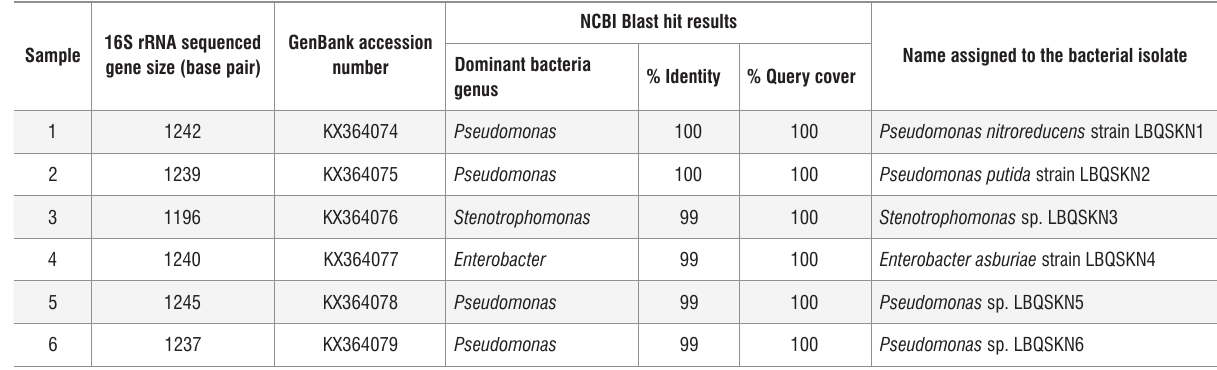
16S rRNA sequenced Sample gene size (base pair)